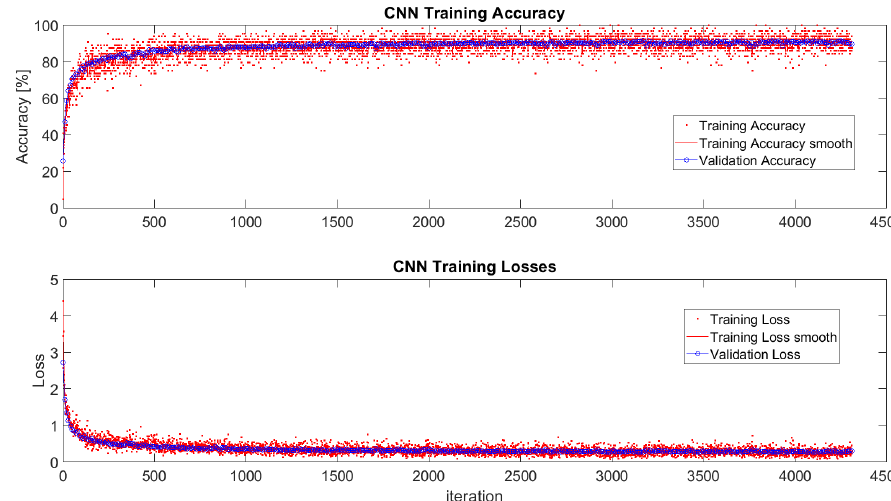
Figure 16. Evolution of the CNN